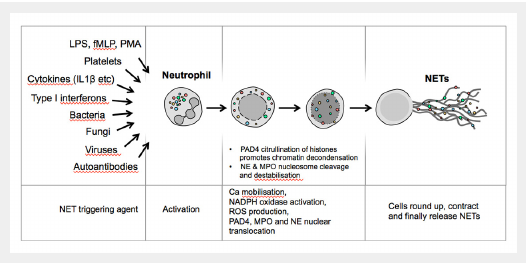
Various stimuli induce neutrophils to form neutrophil extracellular traps. fMLP = N-formyl-methionyl-leucyl-phenylalanine; IL = interleukin; LPS = lipopolysaccharide; MPO = myeloperoxidase; NE = neutrophil elastase; NET = neutrophil extracellular trap; PAD = peptidyl arginine deiminase; PMA = phorbol myristate acetate; ROS = reactive oxygen